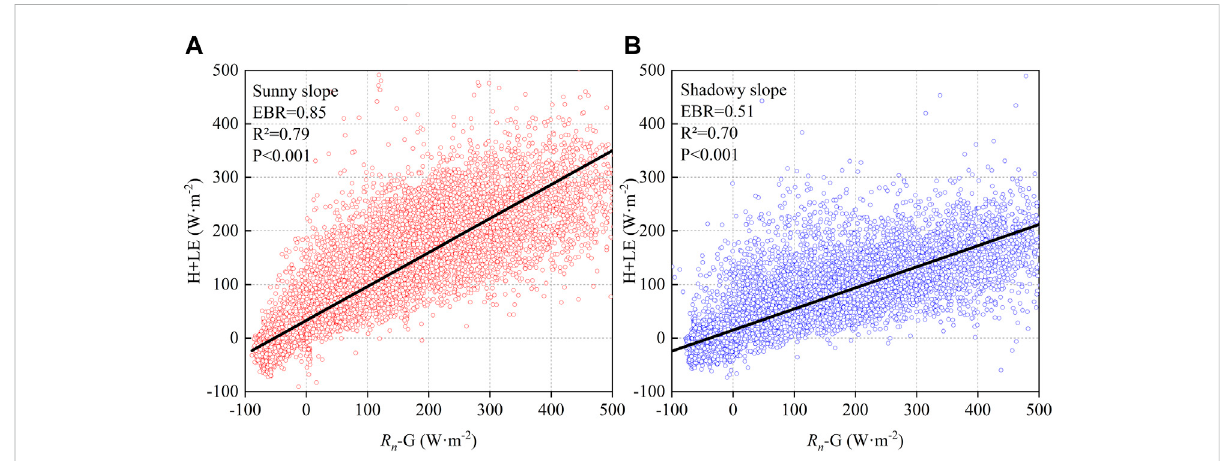
FIGURE 5 (H + LE) and (Rn-G) linear regression analysis of shadowy and sunny slope. (A) Linear regression analysis of sunny slope; (B) Linear regression analysis of shadowy slope.